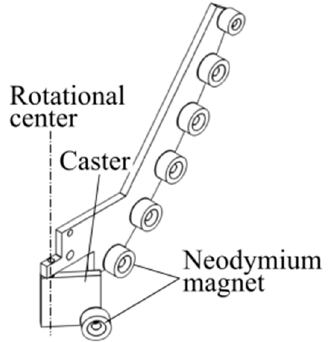
Figure 7. Magnetic rear wheels with a caster.